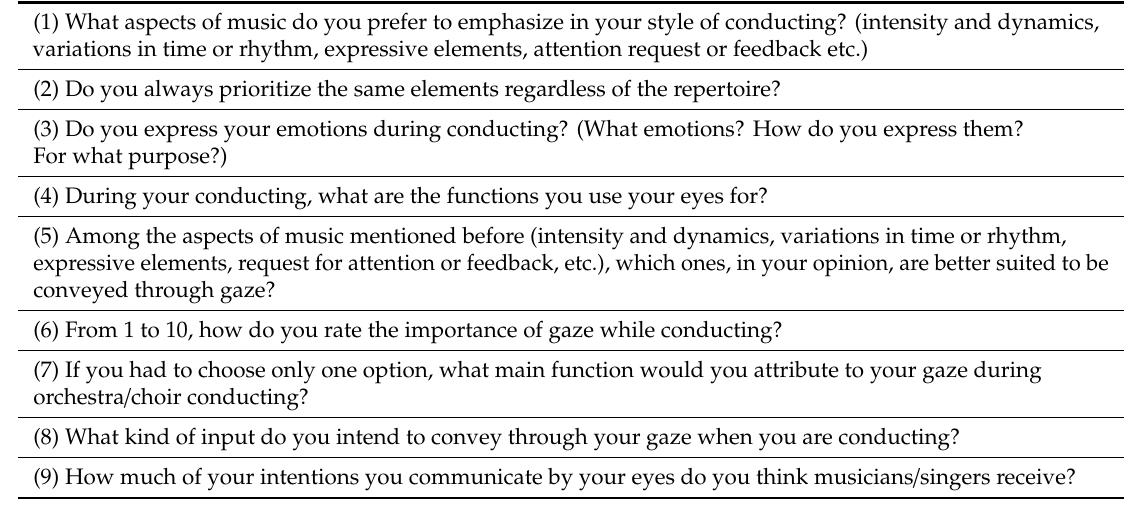
Table 2. An interview on the use of communicative gaze by